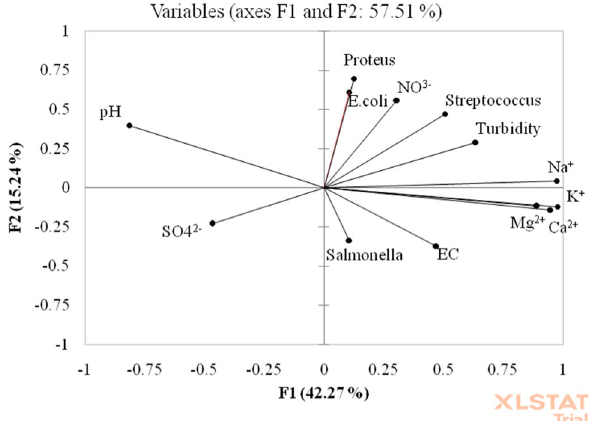
Fig. 7 Graphical representation of the first two principal components of the Mezam water characteristics, extraction method: principal component analysis ( n = Yambot to 28.5 µS/cm at the Ayaba Segment. In fact, EC for the downstream sampling points at Nkimefueh, Ayaba and Lower Ngomgham always portrays excess values of 50 µS/ cm, which could be an indication of anthropogenic sources of ions in water. A mean EC value of 421.54 µS/cm has been reported by Engome et al. (2013) in the Rio del Rey Basin (South West Cameroon).